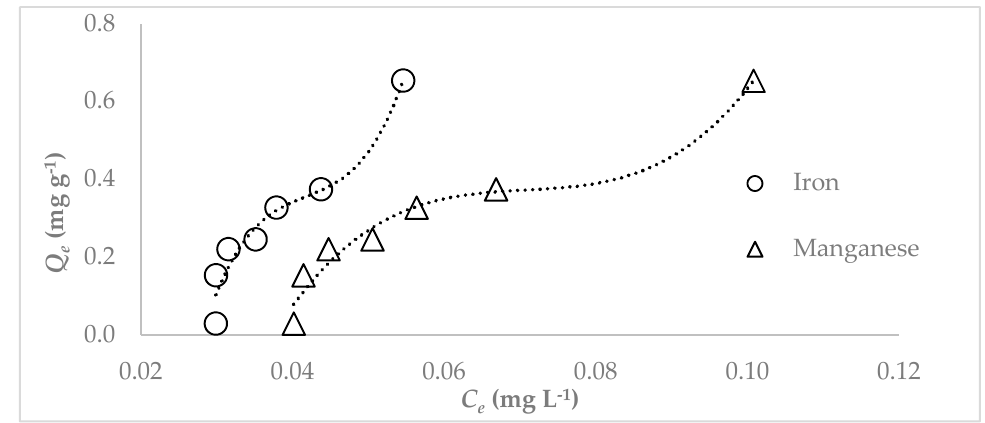
Figure 6. Graph obtained for iron and manganese uptake onto zeolite Y during adsorption studies. Initial Fe = 1.15 mg L − 1 ; Initial Mn = 1.61 mg L − 1 ; adsorbent dose = 1.0, 2.0, 2.5, 3.0, 3.0, 4.0 and 4.5 g L − 1 , T = 25 °C; water pH = 6.5.